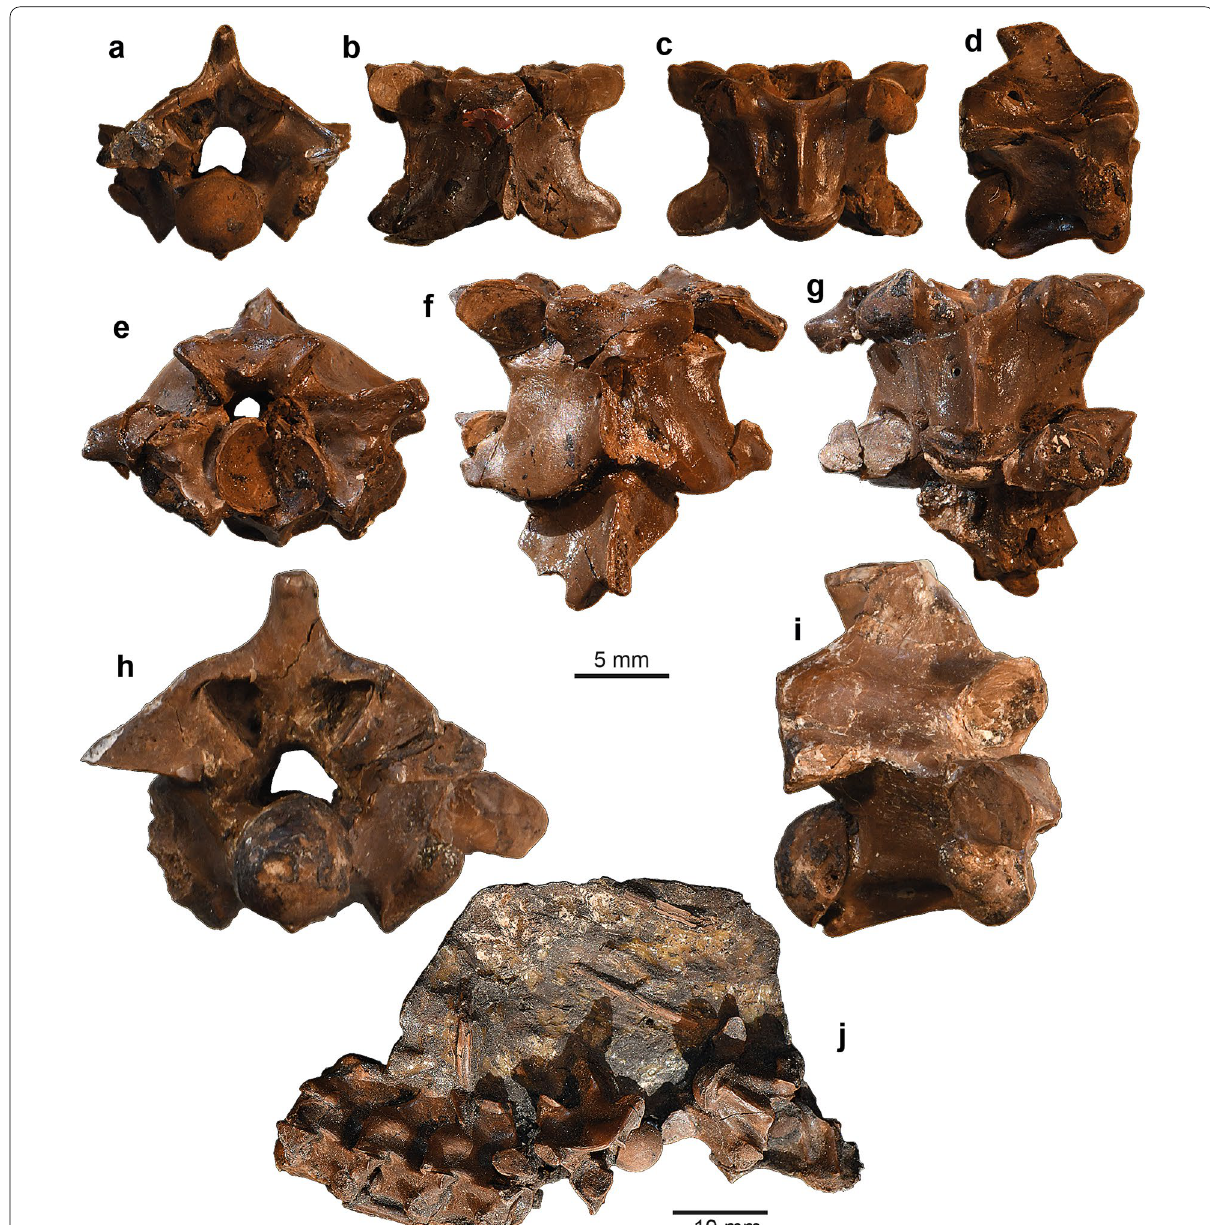
Fig. 58 Eoconstrictor cf. fischeri from quarry XLI, Geiseltal: a – d mid-trunk vertebra (GMH XLI-155a-1966) in posterior ( a ), dorsal ( b ), ventral ( c ), and right lateral ( d ) views; e – g mid-trunk vertebra with fragment of articulated succeeding vertebra (GMH XLI-314c-1968) in anterior ( e ), dorsal ( f ), and ventral ( g ) views; h , i posterior trunk vertebra (GMH XLI-148–1966) in posterior ( h ) and right lateral ( i ) views; j string of articulated vertebrae and some ribs (GMH